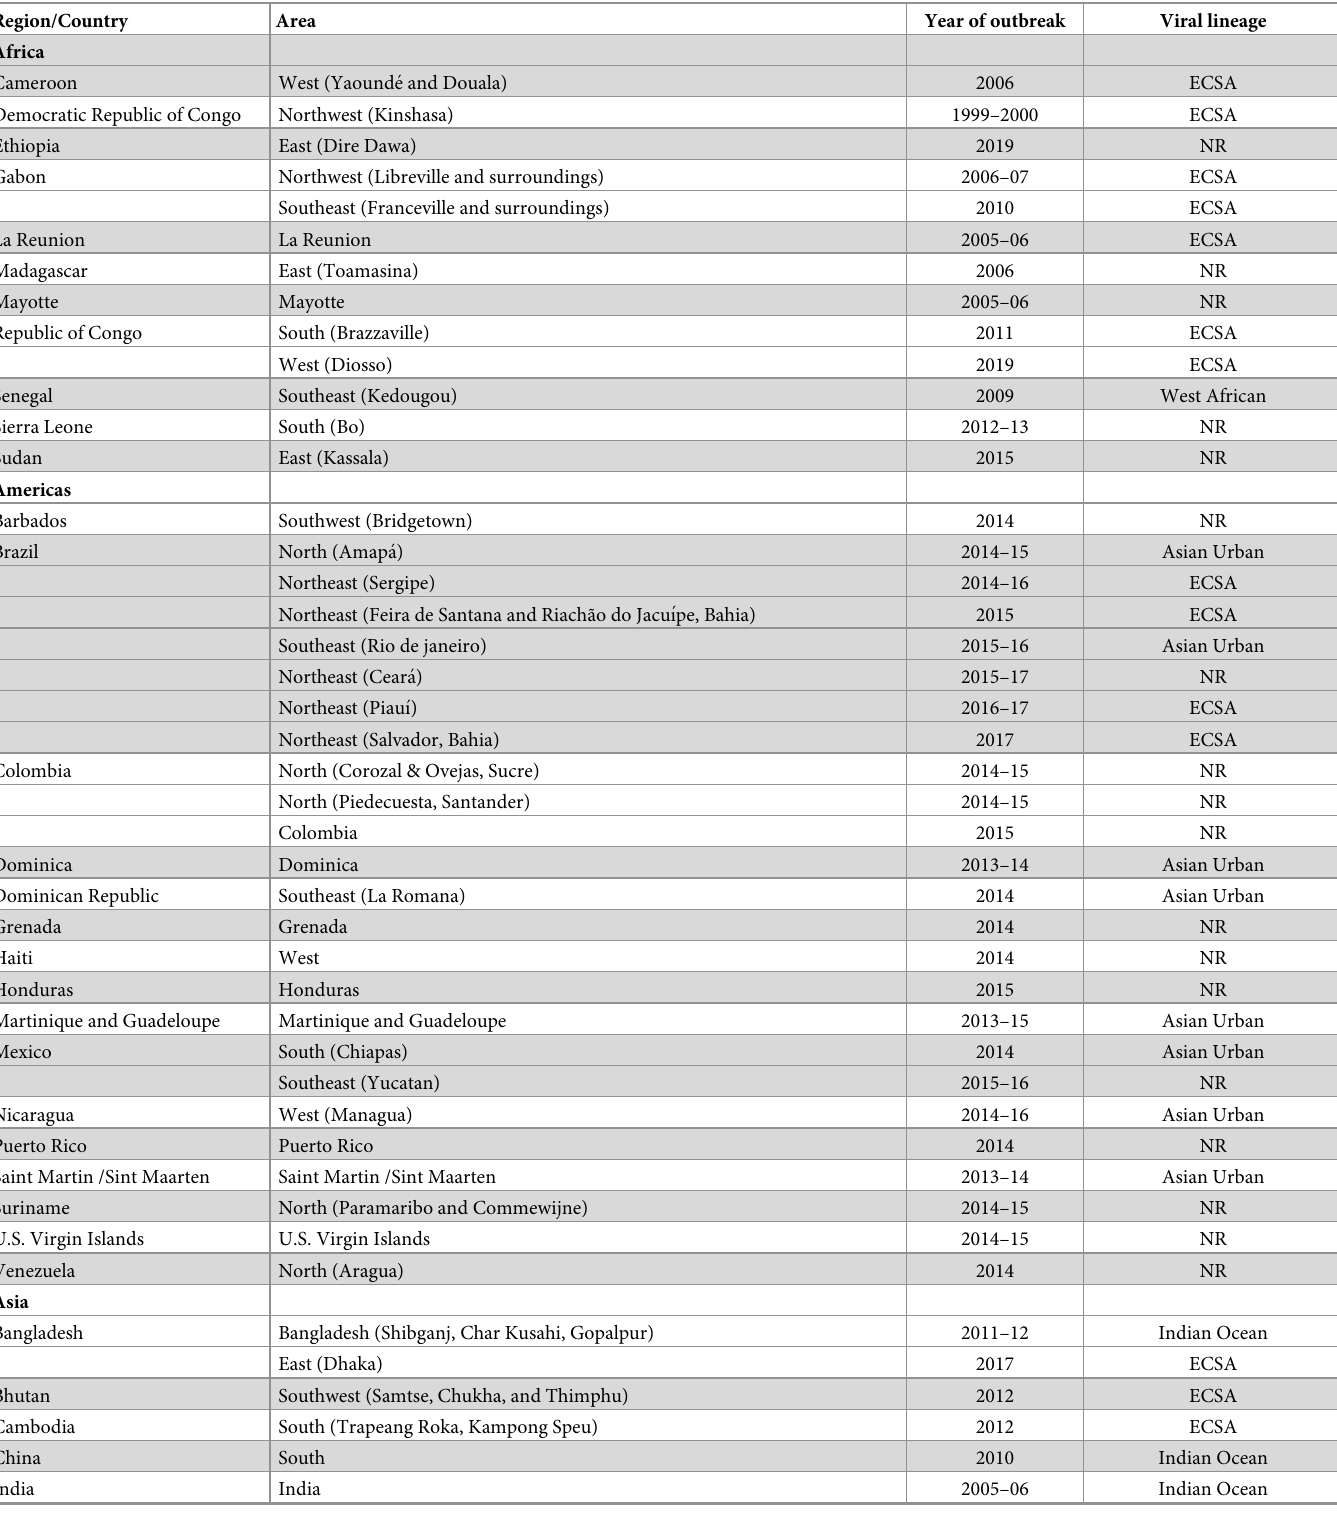
Table 1. Chikungunya outbreaks by region and country, 1999–2020.